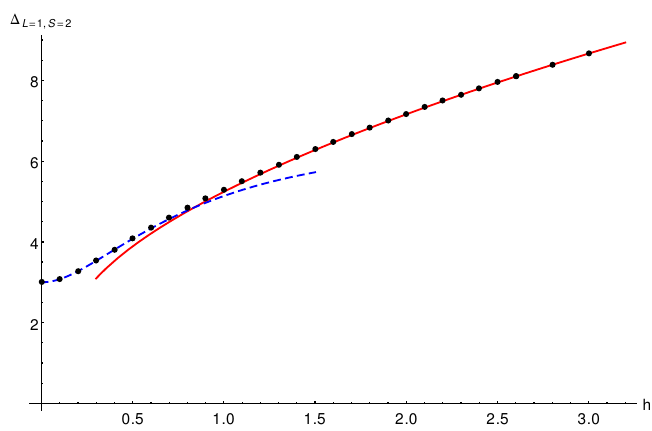
Figure 8 . Plot of (cid:1) L =1 ;S =2 as a function of h : the dots correspond to the numerical data reported in table 7 of appendix D.1, while the solid line and the dashed line represent the strong coupling expansion (4.15) and the weak coupling Pad(cid:19)e approximant (4.14),